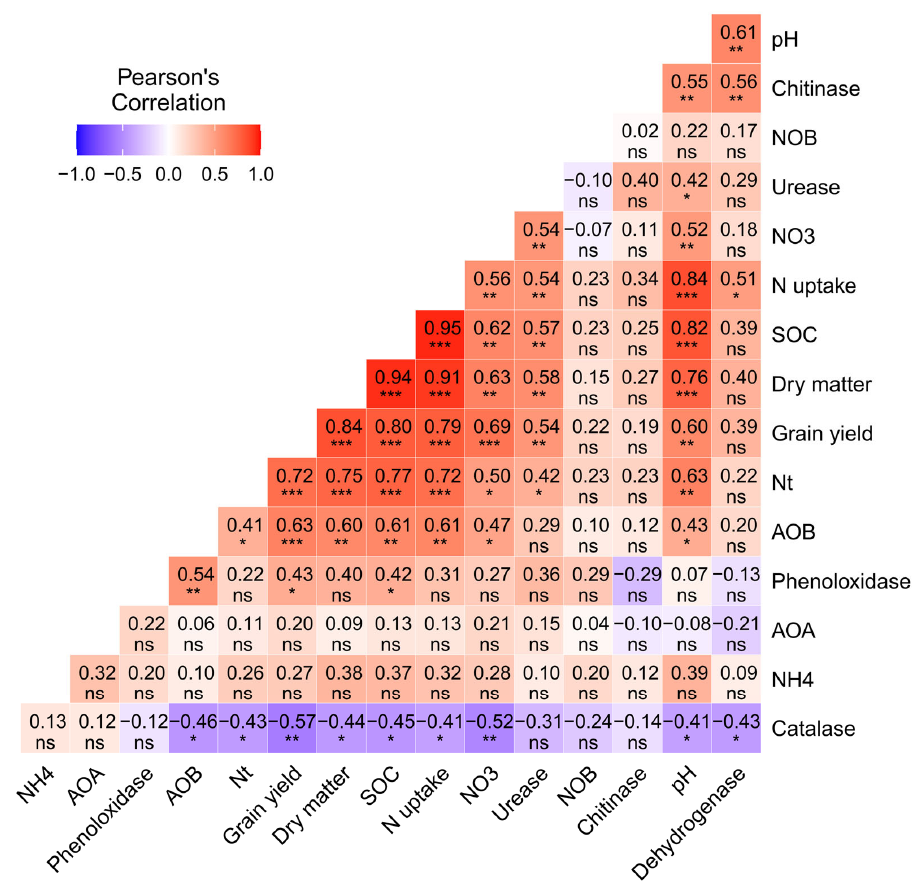
Figure 7. Correlation heat map of soil properties; enzyme activities; abundances of AOB, AOA, and NOB; N uptake; DM; and grain yield of rice. Red colors indicate positive relationships, and dark blue colors indicate negative relationships. The colors carried from white to red and white to blue indicate moderately to strong positive/negative correlations, respectively. Note: SOC; soil organic carbon, Nt; total nitrogen, NH 4 ; ammonium nitrogen concentration, NO 3 ; nitrite nitrogen concentration, AOB; ammonium-oxidizing bacteria, AOA; ammonium-oxidizing archaea, NOB; nitrite-oxidizing bacteria. * indicate the significant difference at ( p < 0.05), ** indicate the significant difference at ( p < 0.01), and *** indicate the significant difference at ( p < 0.001), whereas ns indicate non-significant ( p ≥ 0.05).